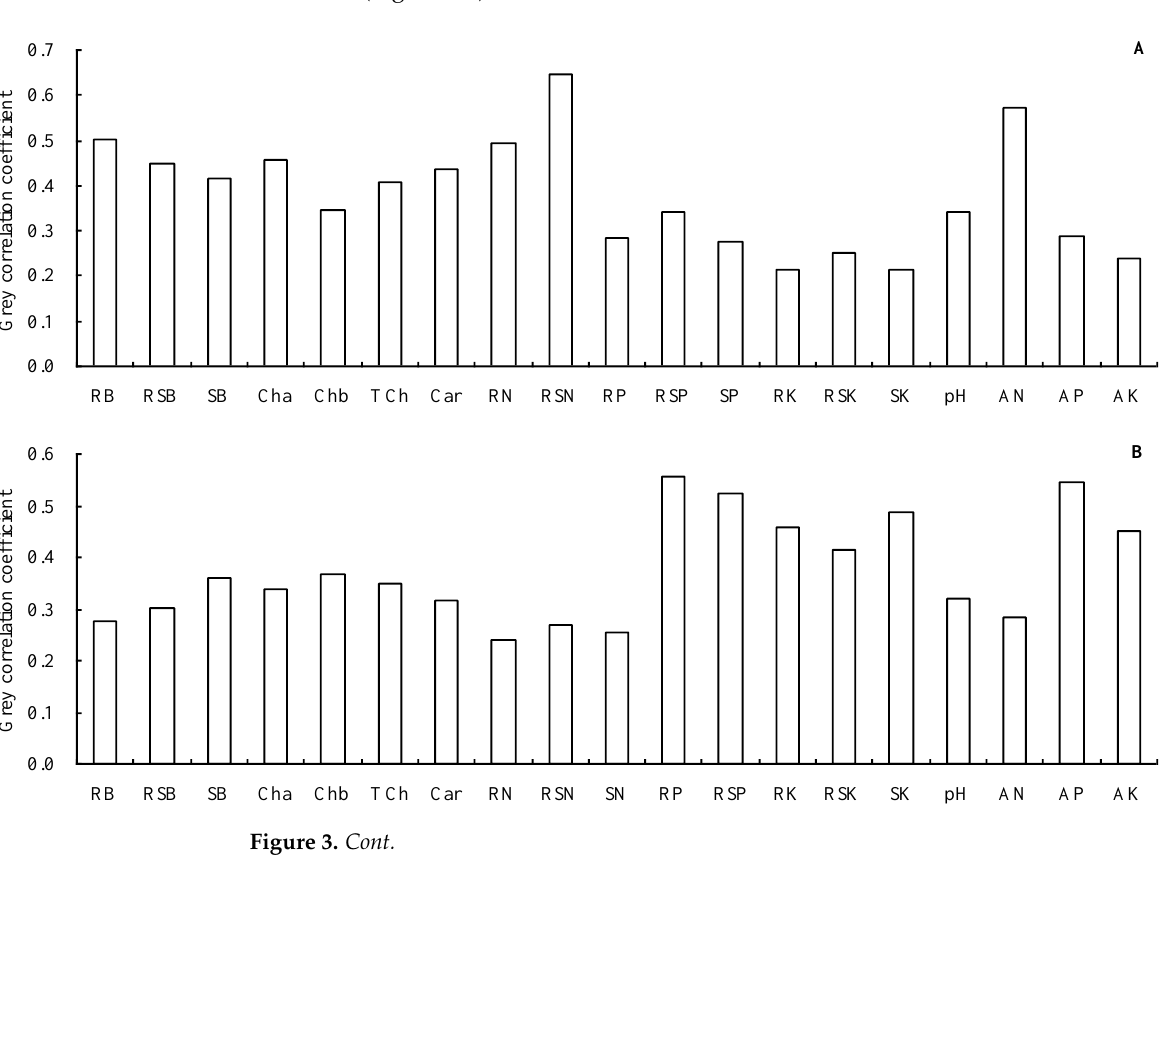
Figure 3. Grey correlation coefficients. ( A ) Grey correlation coefficient of the biomass, photosyn- thetic pigment content, rootstock root total N content, rootstock stem total N content, total P content, and total K content with the scion total N content; ( B ) grey correlation coefficient of the biomass, photosynthetic pigment content, total N content, rootstock root total P content, rootstock total P content, and total K content with the scion total P content; ( C ) grey correlation coefficient of the biomass, photosynthetic pigment content, total N content, total P content, rootstock root total K content, and rootstock stem total K content with the scion total K content. RB — rootstock root bio- mass; RSB — rootstock stem biomass; SB — scion biomass; Cha — chlorophyll a content; Chb — chloro- phyll b content; TCh — total chlorophyll content; Car — carotenoid content; RN — rootstock root total N content; RSN — rootstock stem total N content; SN — scion total N content; RP — rootstock root total P content; RSP — rootstock stem total P content; SP — scion total P content; RK — rootstock root total K content; RSK — rootstock stem total K content; SK — scion total K content; pH — soil pH value; AN — alkali-hydrolyzable N concentration; AP — available P concentration; AK — available K con- centration. In addition, the total P content in various organs had a highly significant ( p < 0.01) positive correlation with the total K content in various organs. The total P and K contents